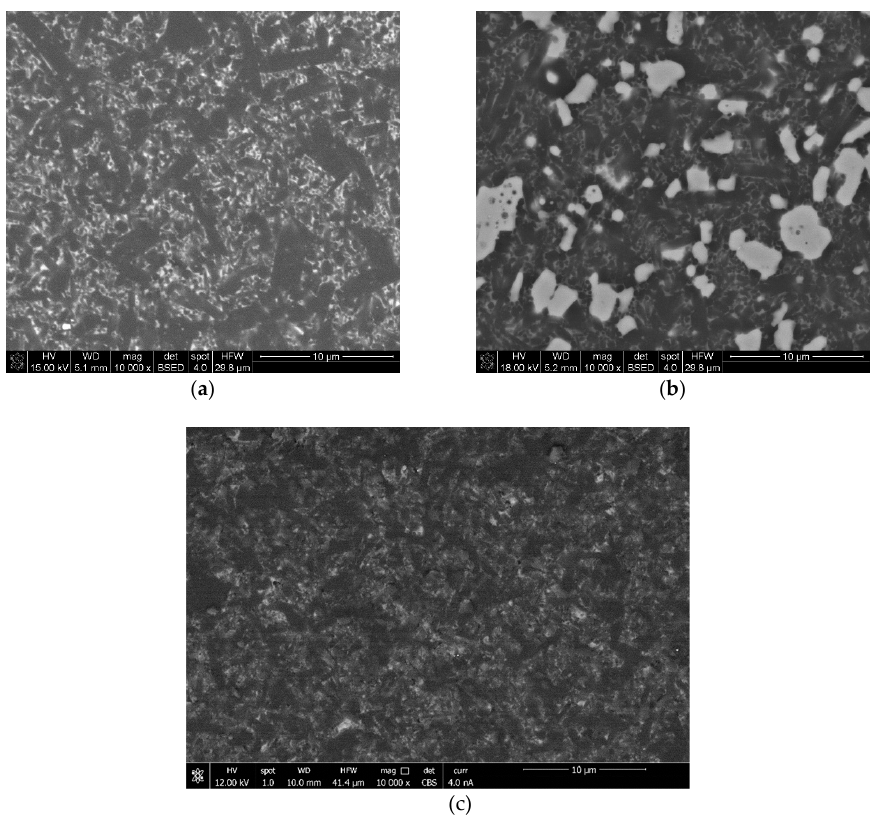
Figure 3. SEM observation of materials: ( a ) polycrystalline Si 3 N 4 , ( b ) Si 3 N 4 + 20%TiN, and ( c ) Si 3 N 4 + 20%SiC.